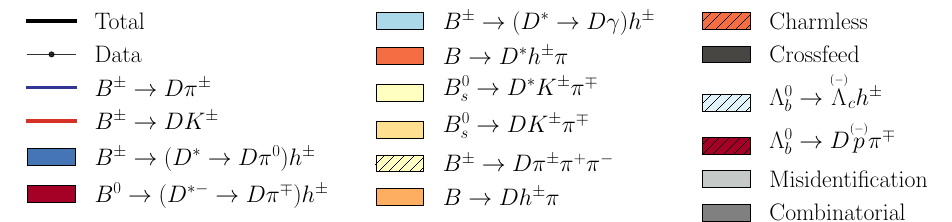
Figure 1 . Legend indicating the invariant-mass fit components shown in figures